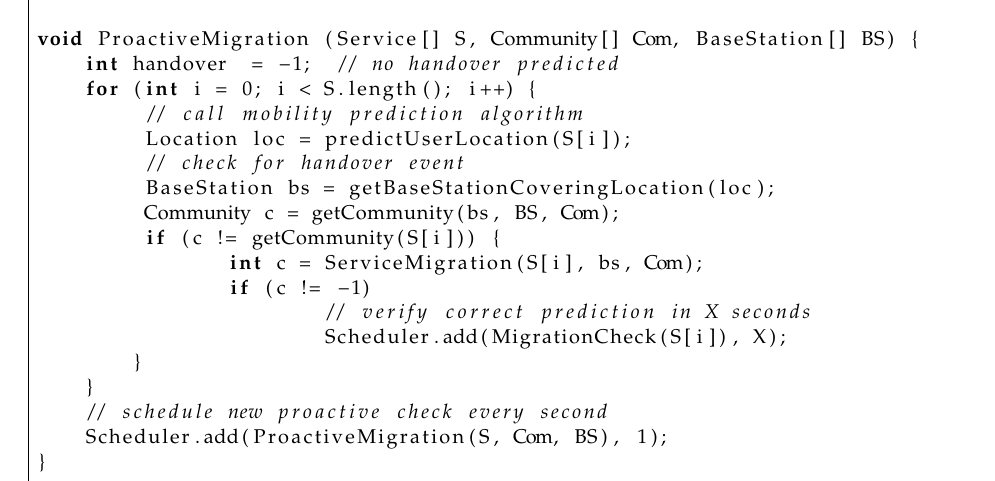
Figure 3. Proactive hierarchical community approach to service migration. Listing 1. Proactive migration check